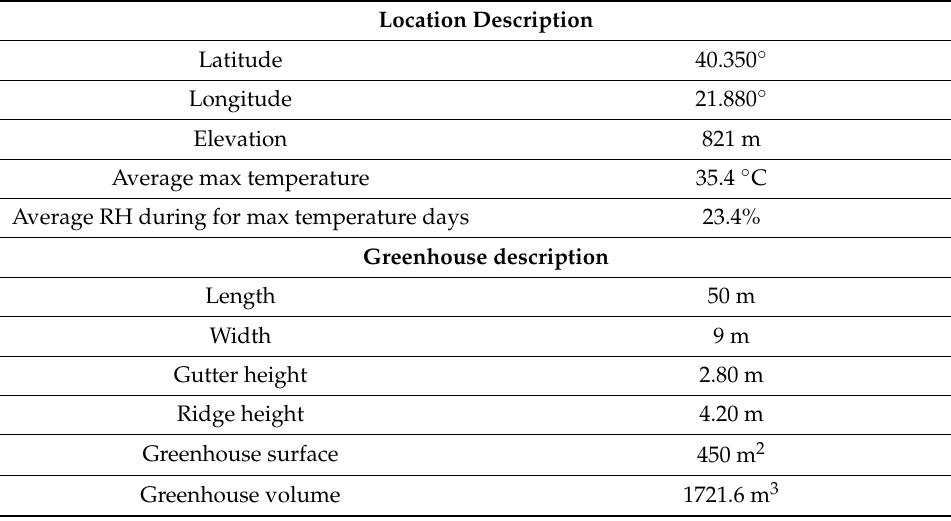
Table 1. Case study region and greenhouse